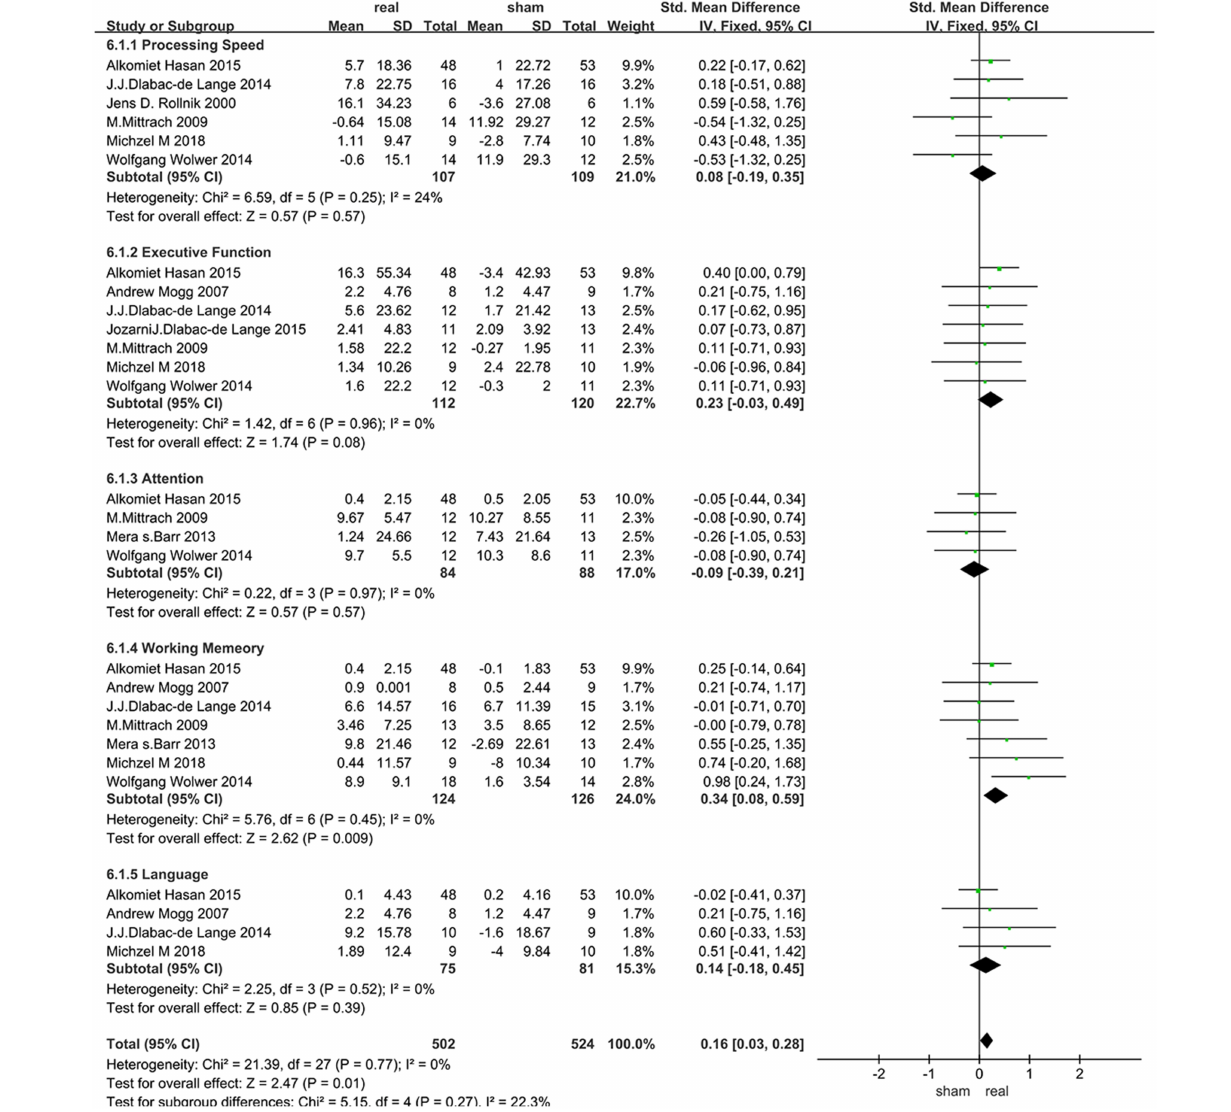
FIGURE 3 | Immediate efficacy in various cognitive domains after rTMS